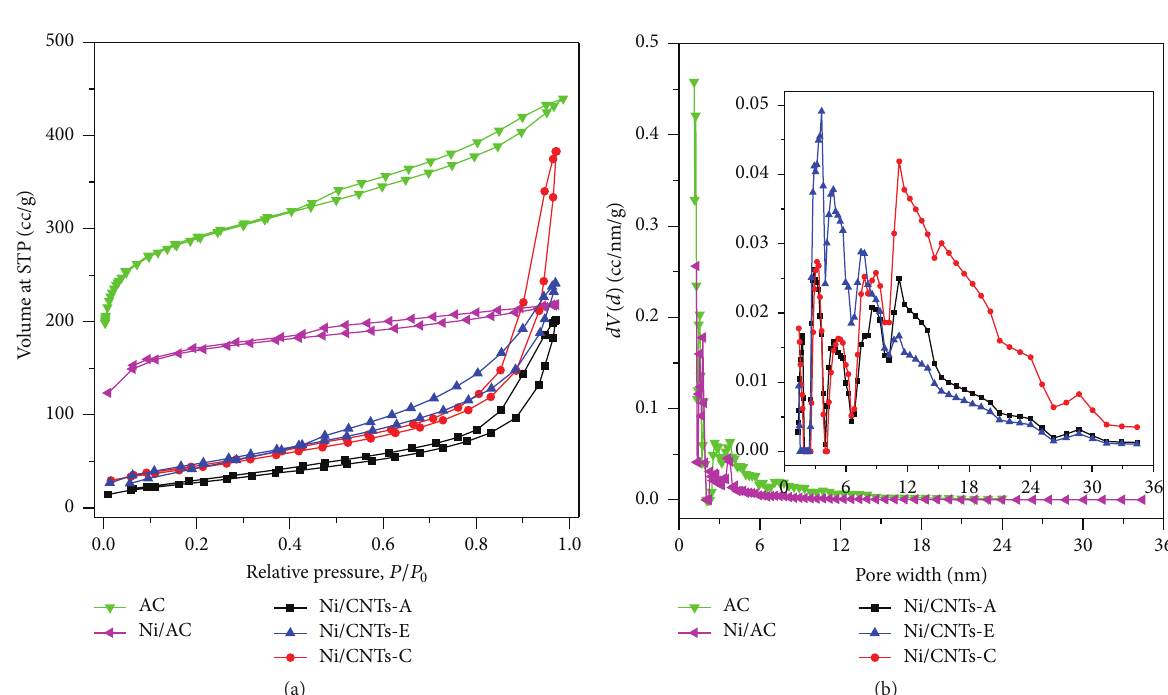
Figure 3: N 2 adsorption/desorption isotherms (77 K) (a) and pore size distributions obtained applying the DFT equation (b) corresponding to the